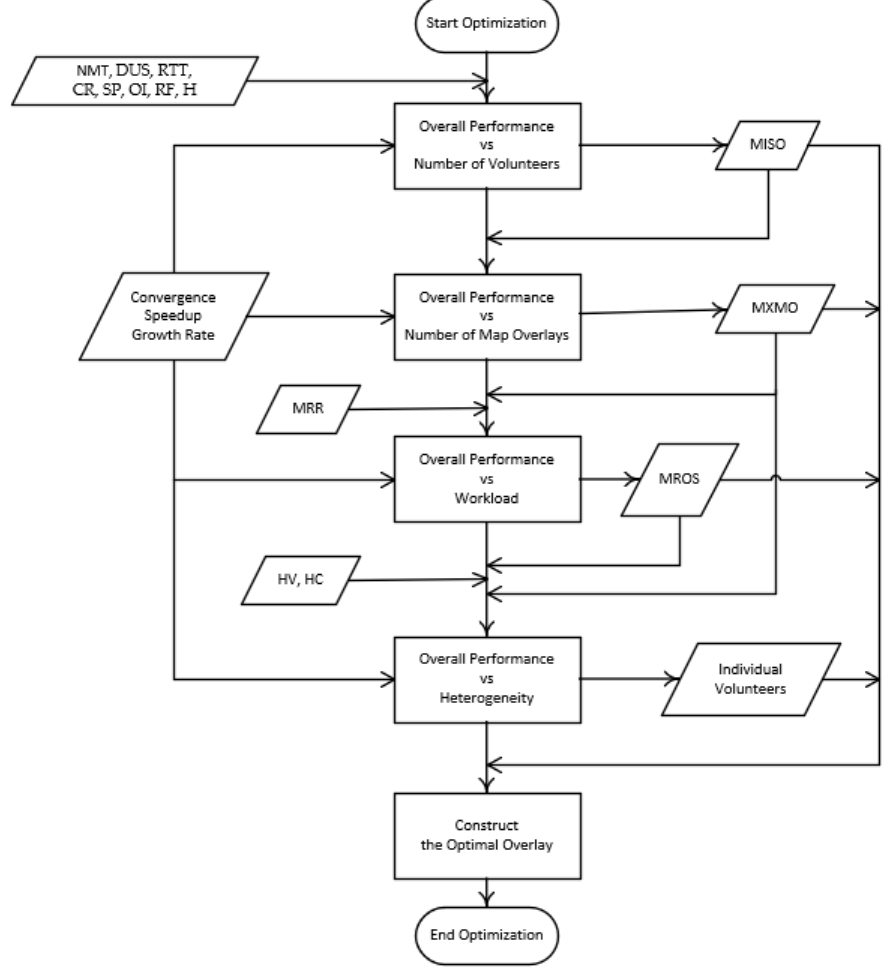
Figure 12. The optimization steps.